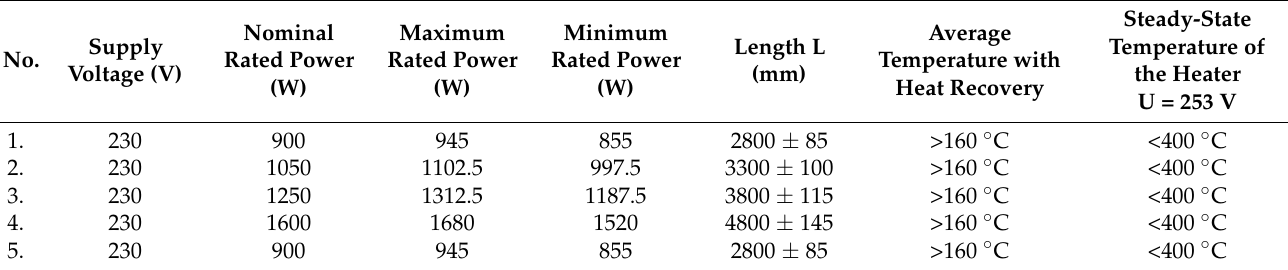
Table 2. Dimensions and wattages of resistor heaters